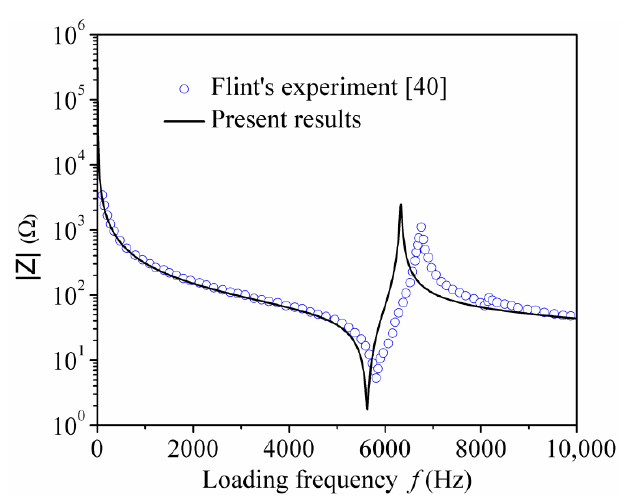
Figure 2. Magnitude of coupled impedance versus loading frequency.